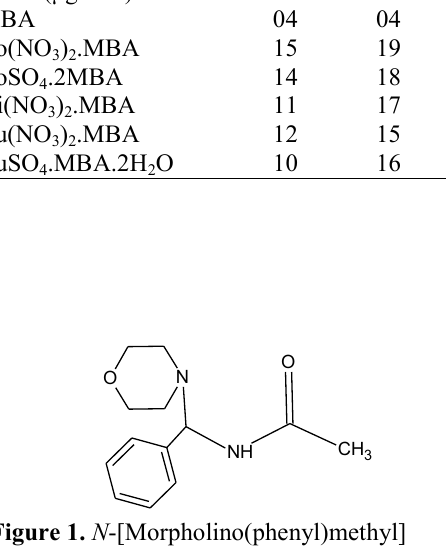
Figure 1. N -[Morpholino(phenyl)methyl] acetamide.